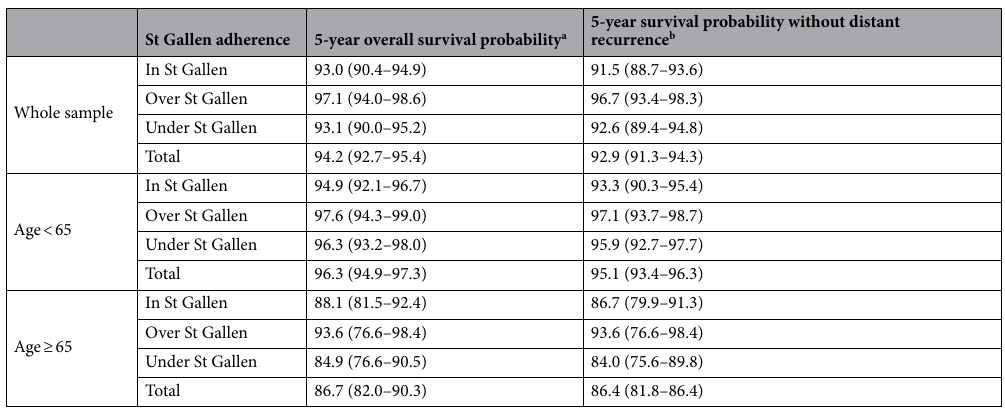
Table 5. Crude Kaplan–Meier estimated survival probabilities according to St Gallen adherence and age at diagnosis. a Event: dead. Censored: patients alive at the end of follow-up. b Event: dead or distant recurrence. Censored: patients alive and without distant recurrence at the end of